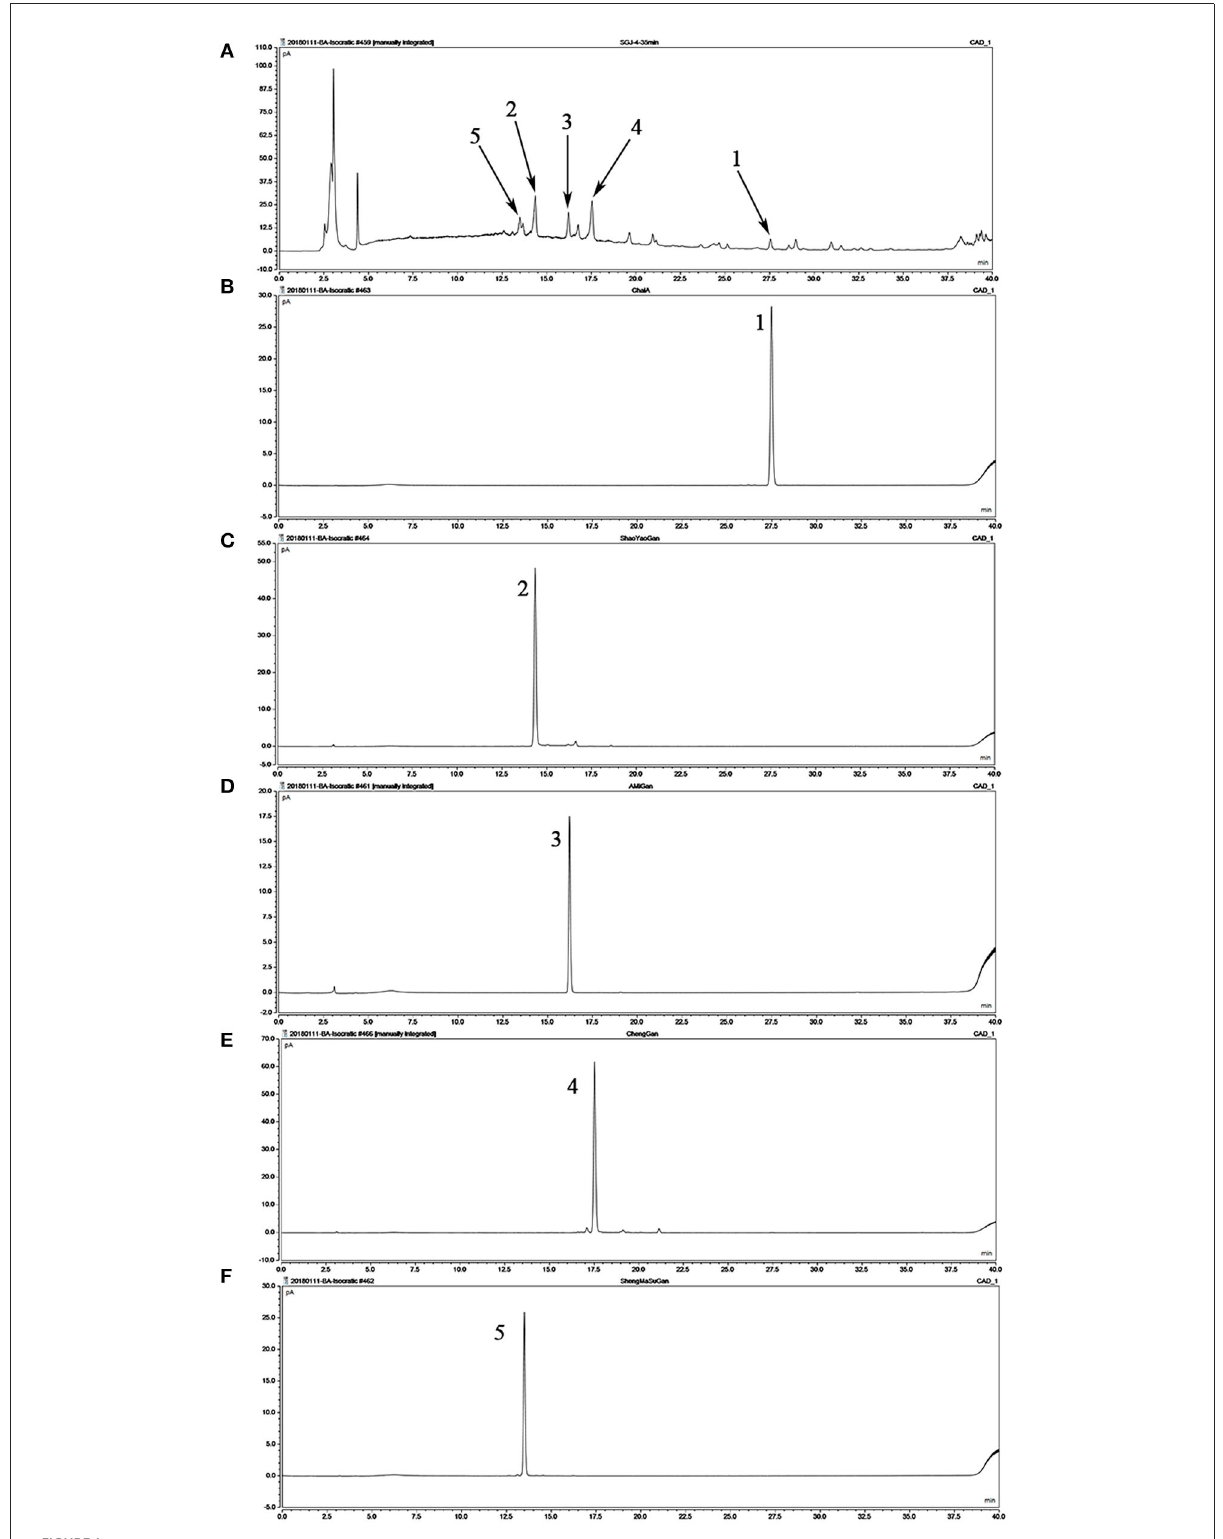
FIGURE1 Analysis of the chemical composition of Shugan decoction (SGD) extract by HPLC. (A) HPLC chromatogram of SGD extract; (B) HPLC chromatogram of saikosaponin A; (C) HPLC chromatogram of paeoniflorin; (D) HPLC chromatogram of 5-O-methylvisammioside; (E) HPLC chromatogram of hesperidin; (F) HPLC chromatogram of cimicifugoside. Peak 1: saikosaponin A; Peak 2: paeoniflorin; Peak 3: 5-O-methylvisammioside; Peak 4: hesperidin; Peak 5: